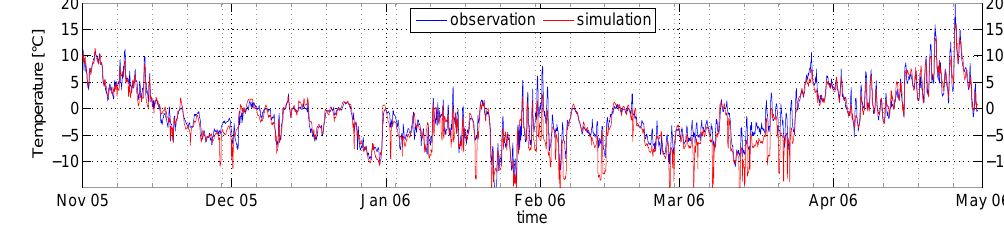
Figure 8. Comparison of simulated and observed temperature time series at the Torfhaus meteorological station.